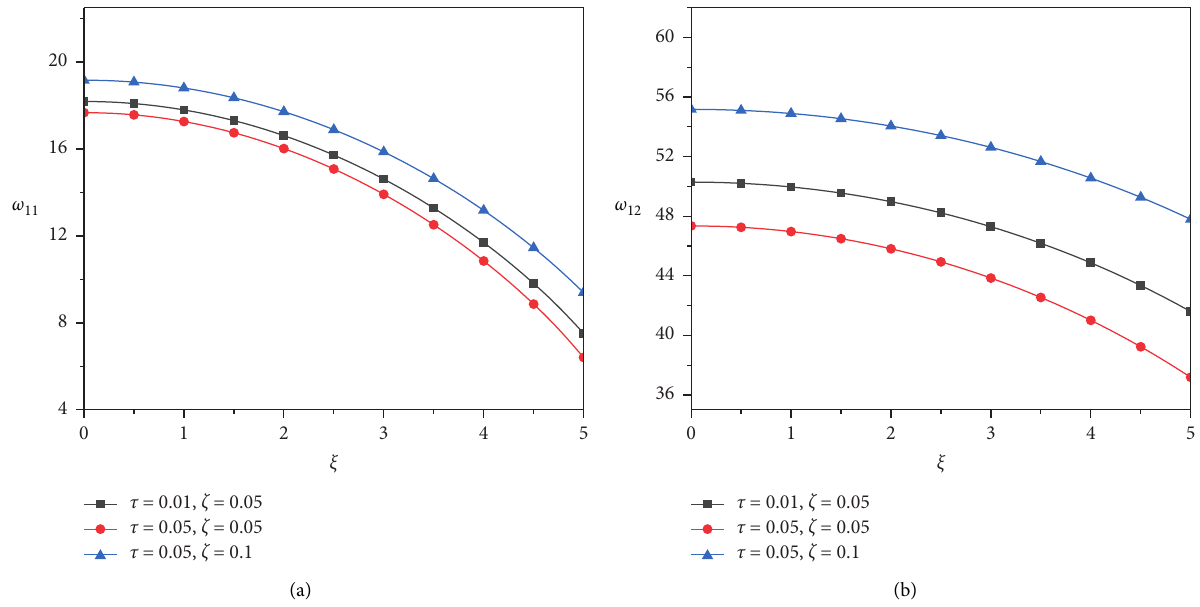
Figure 6: Variation of the vibration frequency with respect to the axial speed under different internal scale parameters. (a) The first-order vibration frequency. (b) The second-order vibration